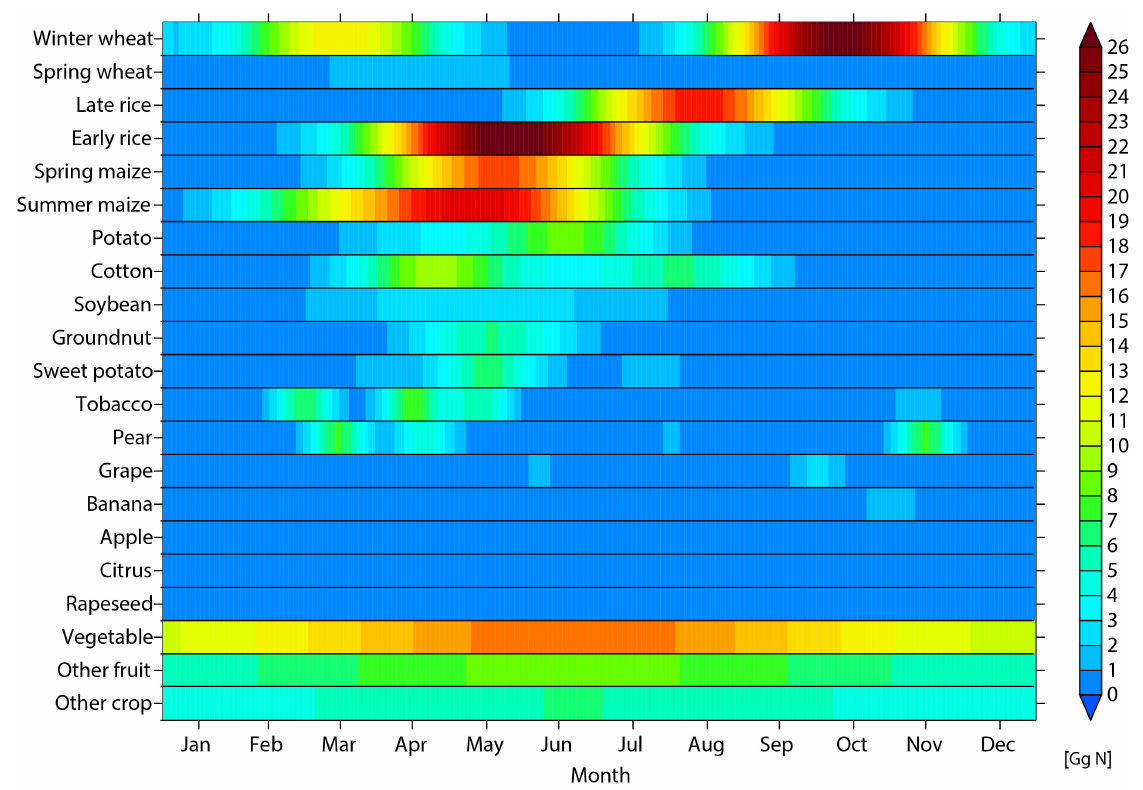
Figure 7. Daily variations of synthetic nitrogen fertilizer application for 18 crops and three groups in China.